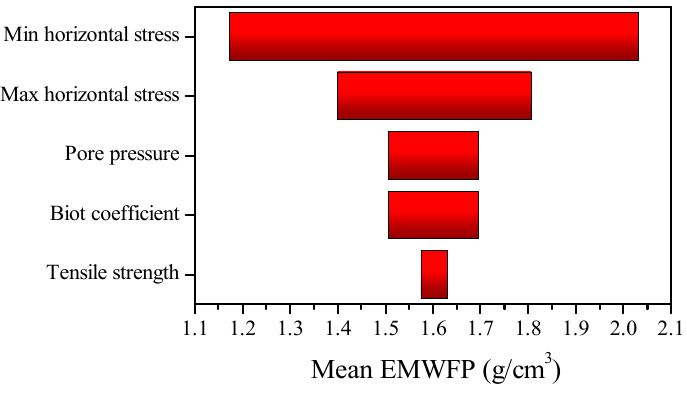
Figure 16. Sensitivity tornado for EMWFP.